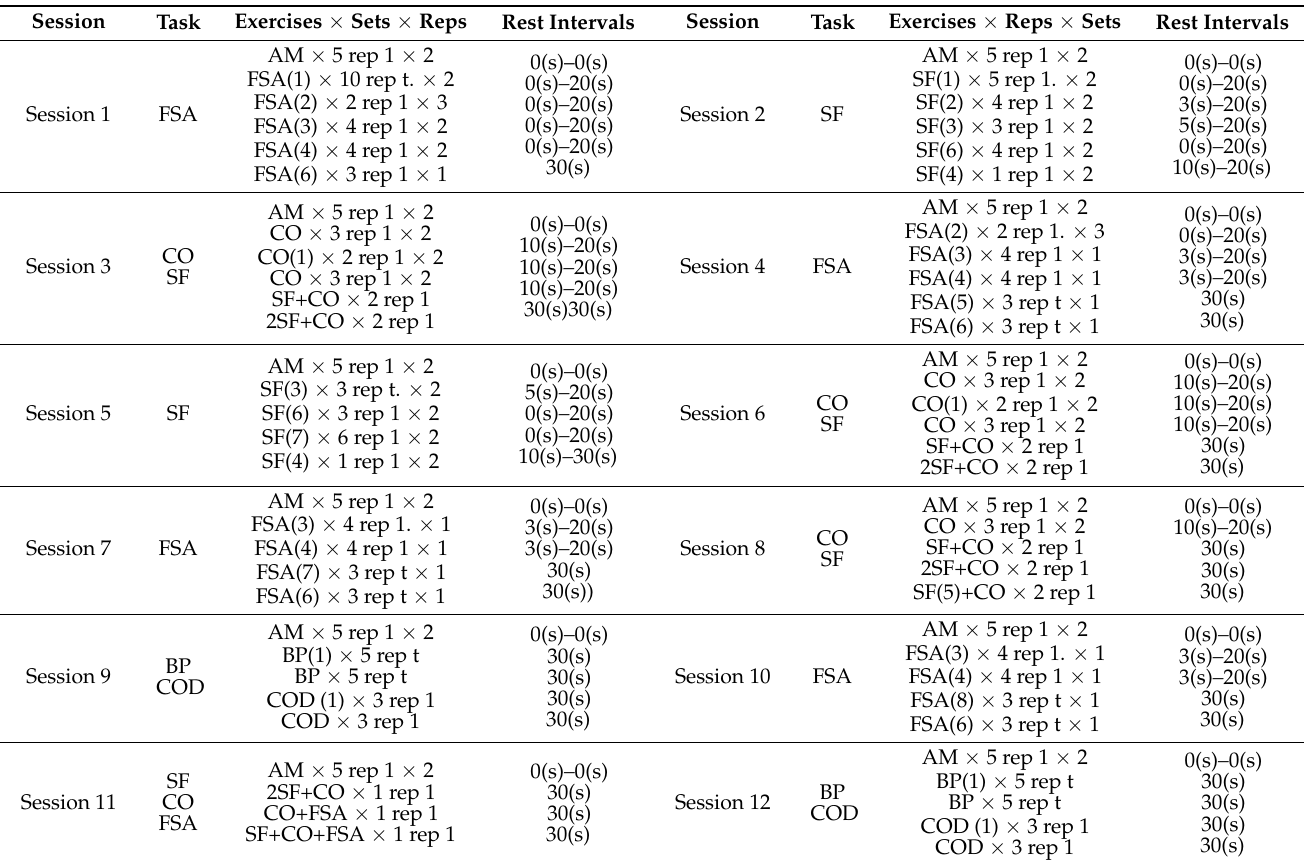
Table 2. Characteristics of the multidirectional running